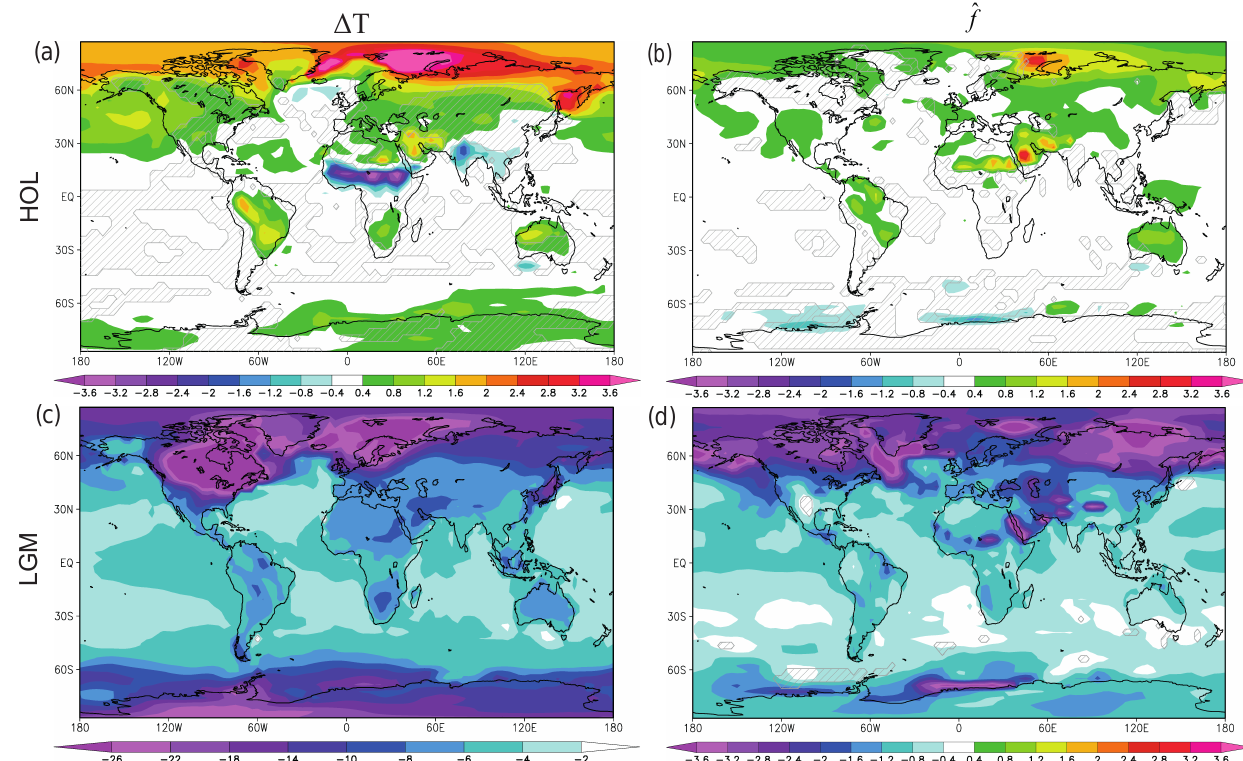
Figure 4. Surface air temperature ( ◦ C) anomalies of a 100-year annual mean climate state with respect to the preindustrial period for (a) mid-Holocene (HOL_sol – PI_sol), (b) mid-Holocene soil feedback ( ˆ f HOL,soil ), (c) Last Glacial Maximum (LGM_sol – PI_sol), (d) Last Glacial Maximum soil feedback ( ˆ f LGM,soil ). A nonlinear scaling is used for the colour bar displayed in panel (c) . Hatched areas identify non-significant values, calculated by means of a Student t test with 0.05 levels of